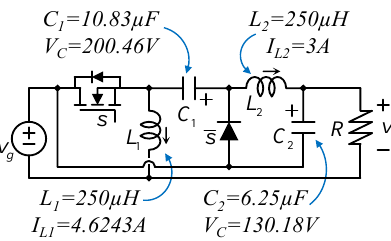
Figure 13. Result of the design with the proposed topology.